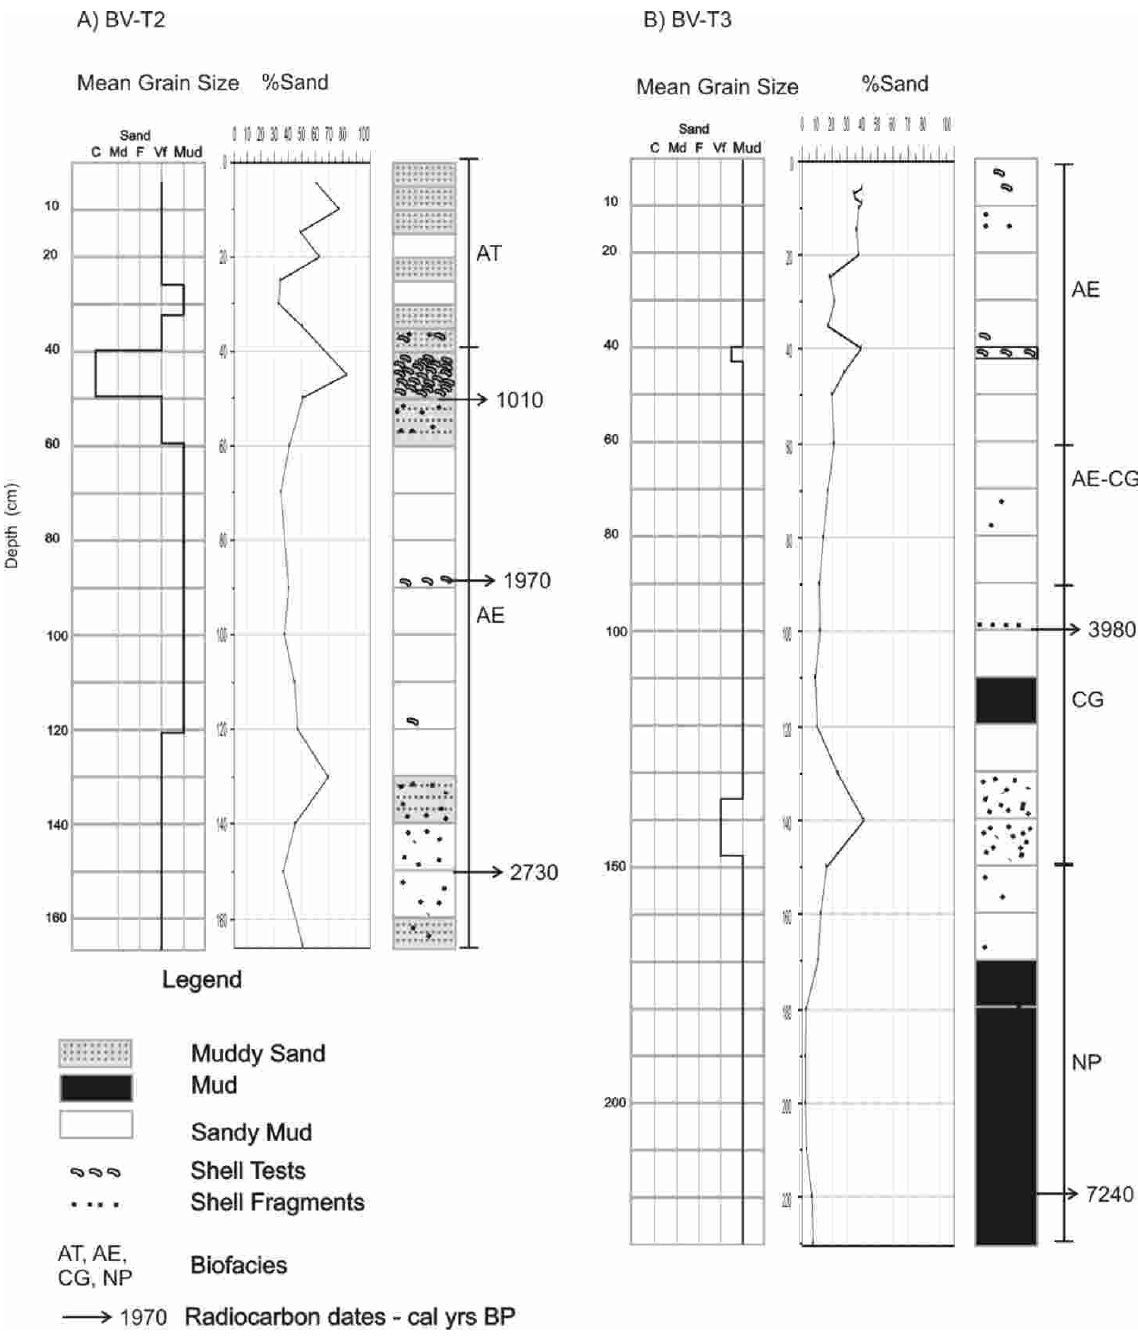
Fig. 5 – Schematic interpretation of BV-T2 (A) and BV-T3 (B), including sediment texture, sand content, biofacies distribution and radiocarbon dates. See text for biofacies